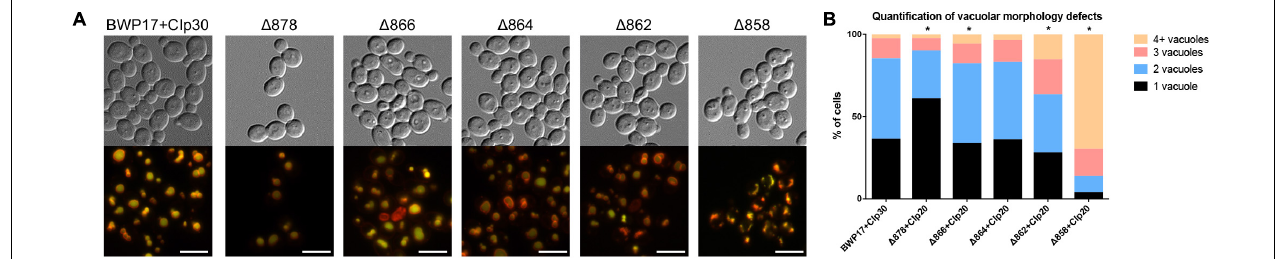
FIGURE 6 | Pma1p is involved in vacuolar morphology. (A) Vacuoles were visualized by co-staining with the vacuolar dyes FM4-64 (membrane, pseudo-colored red) and CDCFDA (lumen, pseudo-colored yellow). Differences in vacuole appearance are most dramatic in the (cid:49) 858 strain, which contains numerous small vacuoles as compared to the BWP17+CIp30 wild-type control. Scale bars indicate 50 µ m. (B) Quantification of vacuole number in FM4-64 and CDCFDA-stained cells. Cells were categorized as containing one, two, three, or four or more vacuoles. Statistical significance was determined using a chi-square goodness-of-fit test comparing vacuole number distribution in the Pma1p truncation mutant strains to vacuole number distribution in the BWP17+CIp30 wild-type control strain. Vacuole number distribution is significantly shifted in the (cid:49) 878, (cid:49) 866, (cid:49) 862, and (cid:49) 858 strains, with the (cid:49) 878 strain exhibiting a shift toward cells containing only one vacuole and the latter strains exhibiting a shift toward cells containing three or more vacuoles. Graph represents a single representative experiment; experiment was conducted twice.